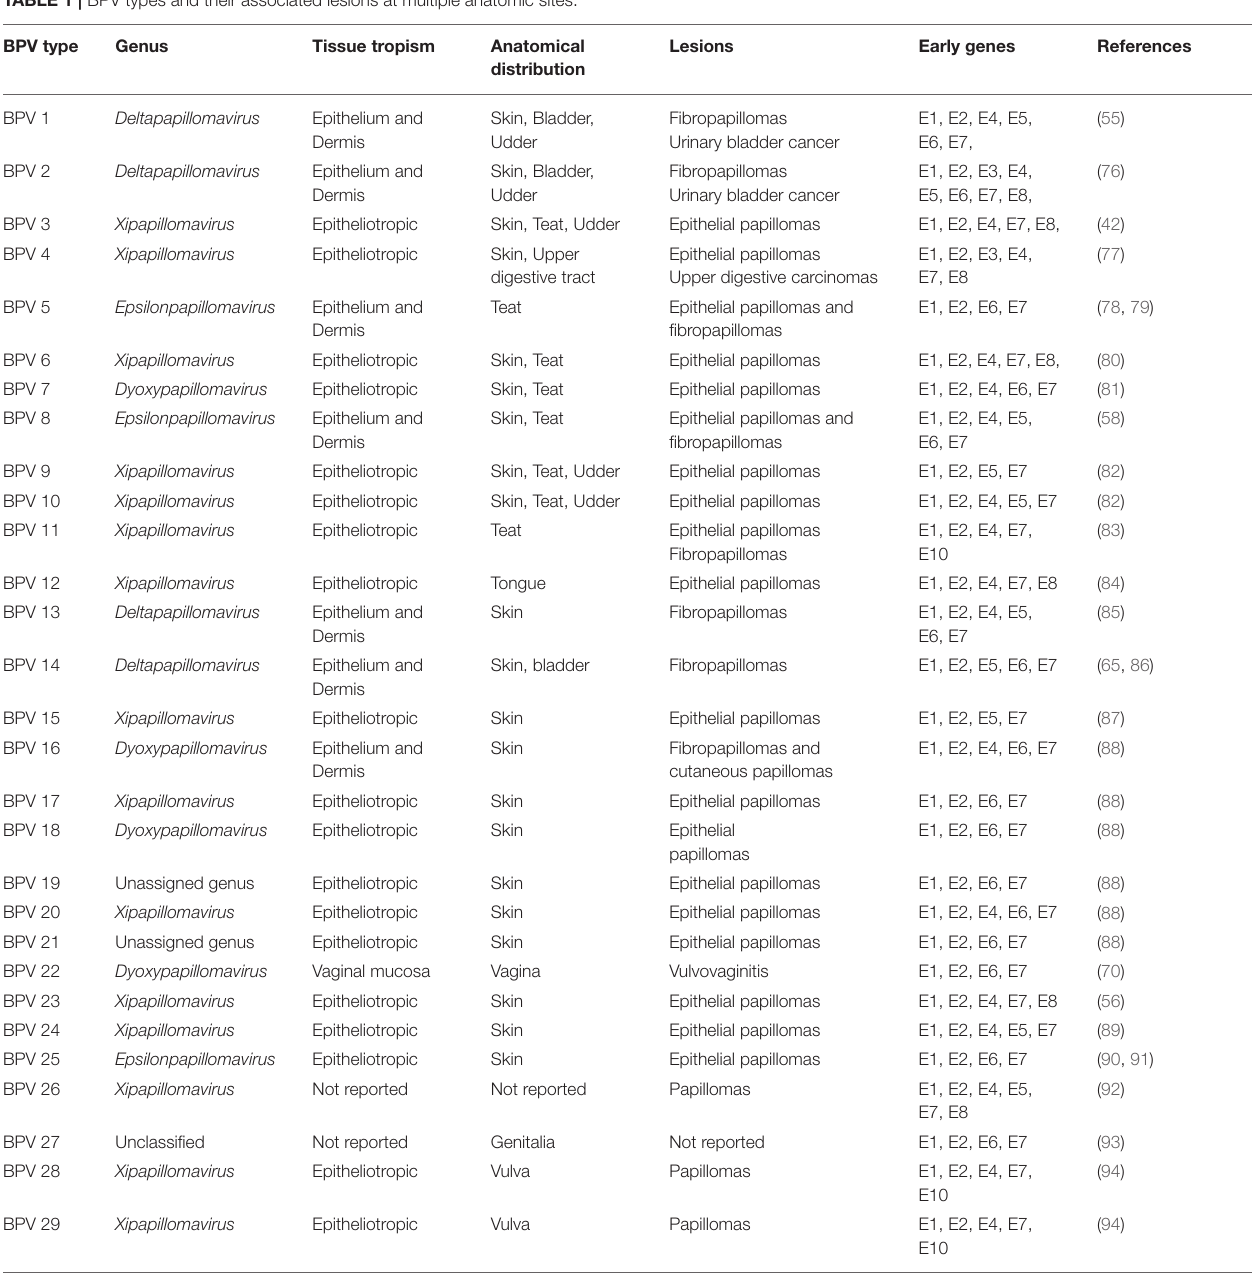
TABLE 1 | BPV types and their associated lesions at multiple anatomic